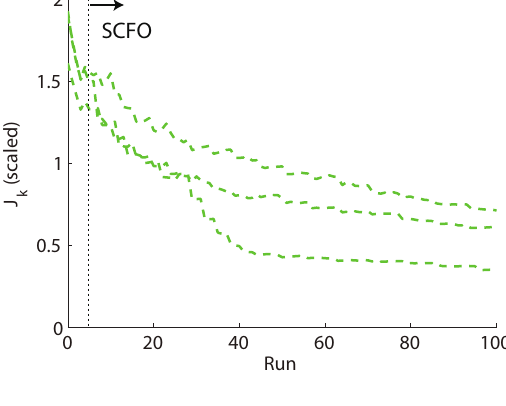
Figure 11. Performance improvement over 100 runs of operation for three different trials (dashed lines) of Problem